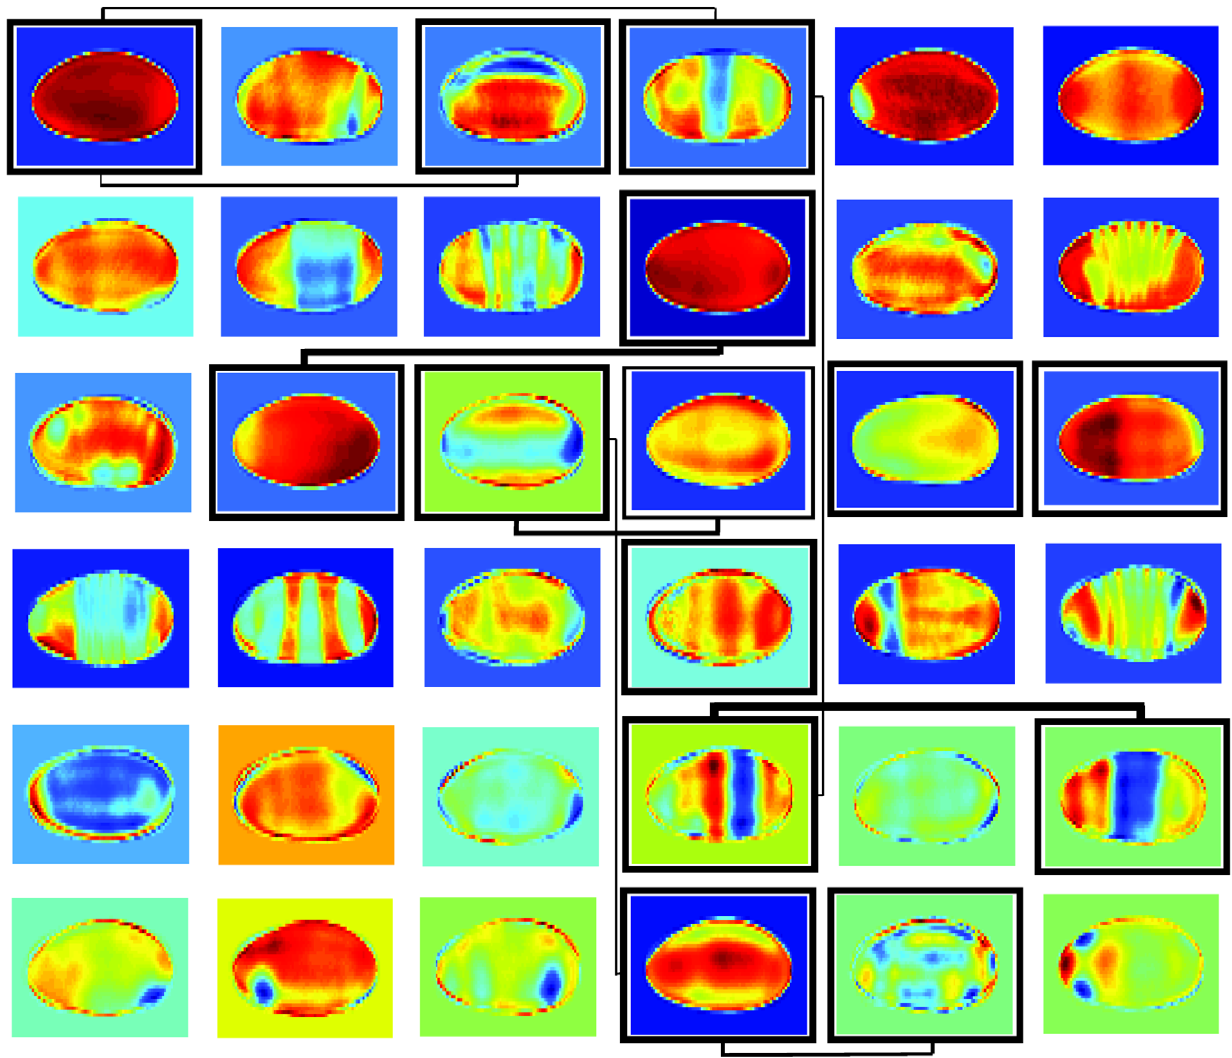
Figure 2. Selected factors estimated from a total of k ~ 60 factors, for a grid size of 80 6 40 (data set S 4 { 6 . As factors can have negative loadings, patterns may be inverse to the in situ staining pattern. The different background colors are an artifact and not part of the model. The bordered factors are the centroids of the largest clusters, while representative occurrences of genes shared among clusters are indicated by the weighted lines.